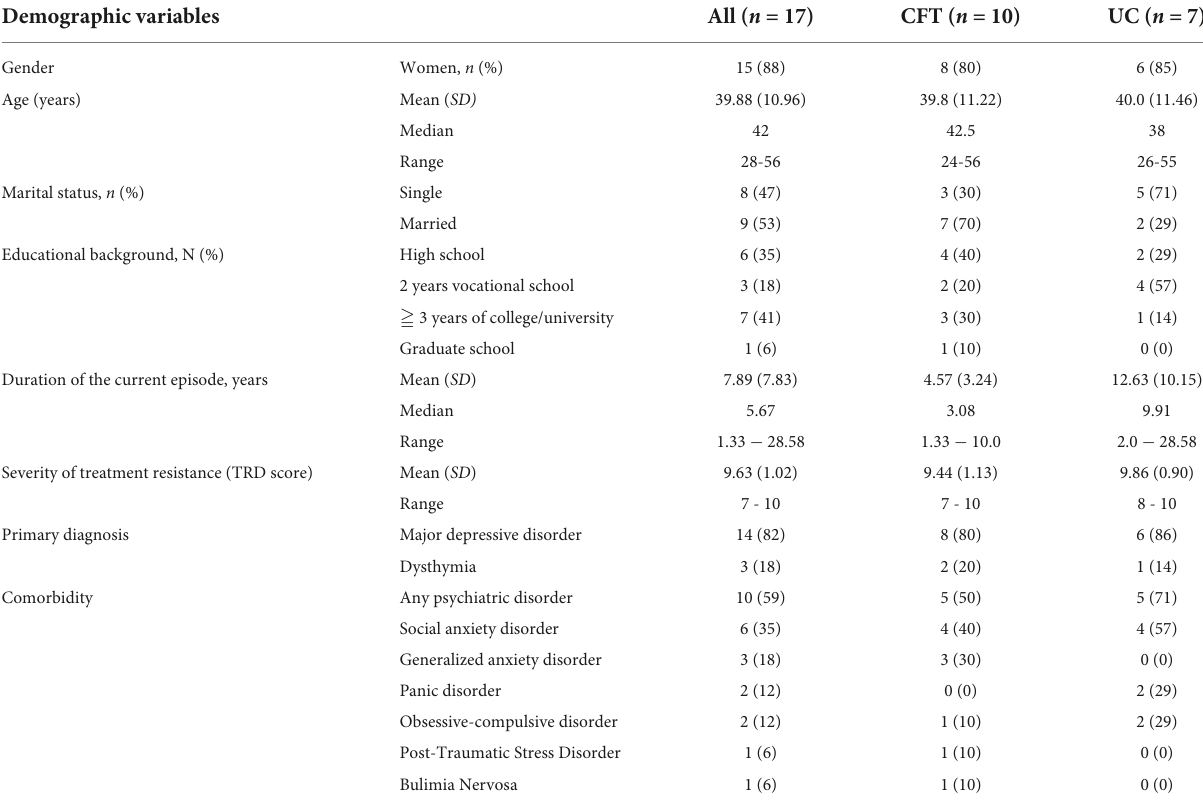
TABLE 2 Participants’